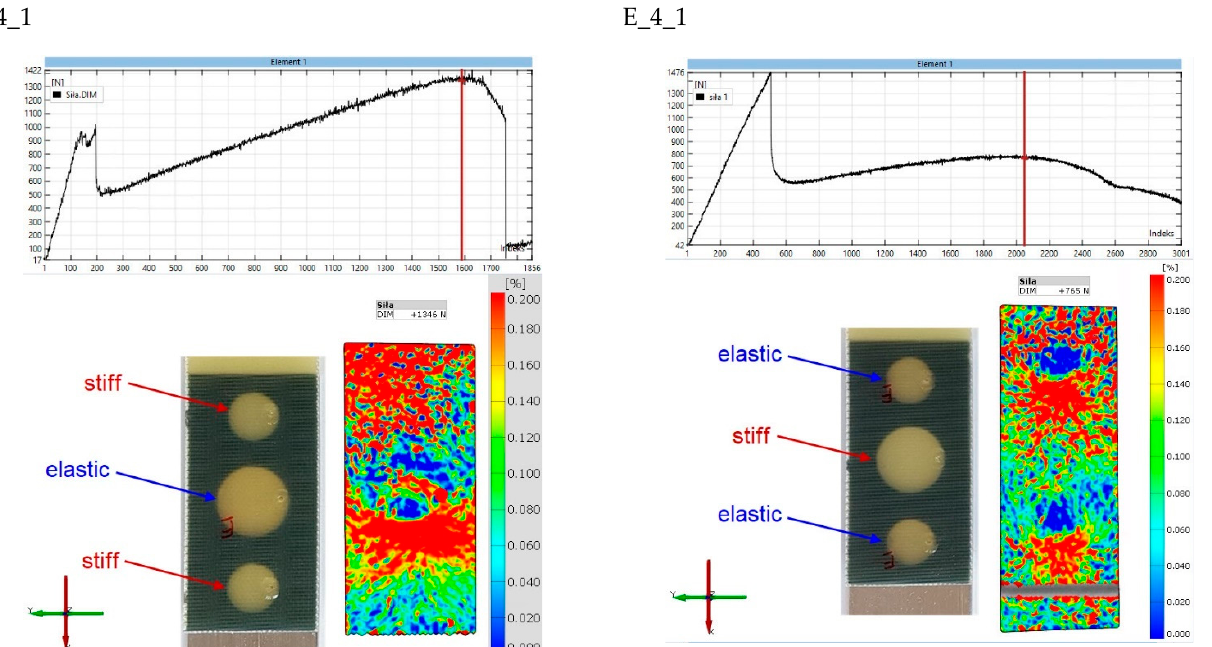
Figure 19. Comparison of principal strain maps for “S” and “E” batch 3 specimens for maximum force in the second stage of operation.